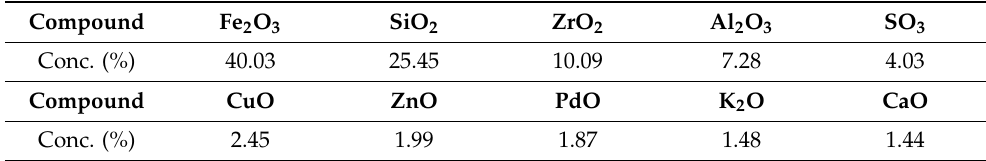
Table 2. Chemical composition of the